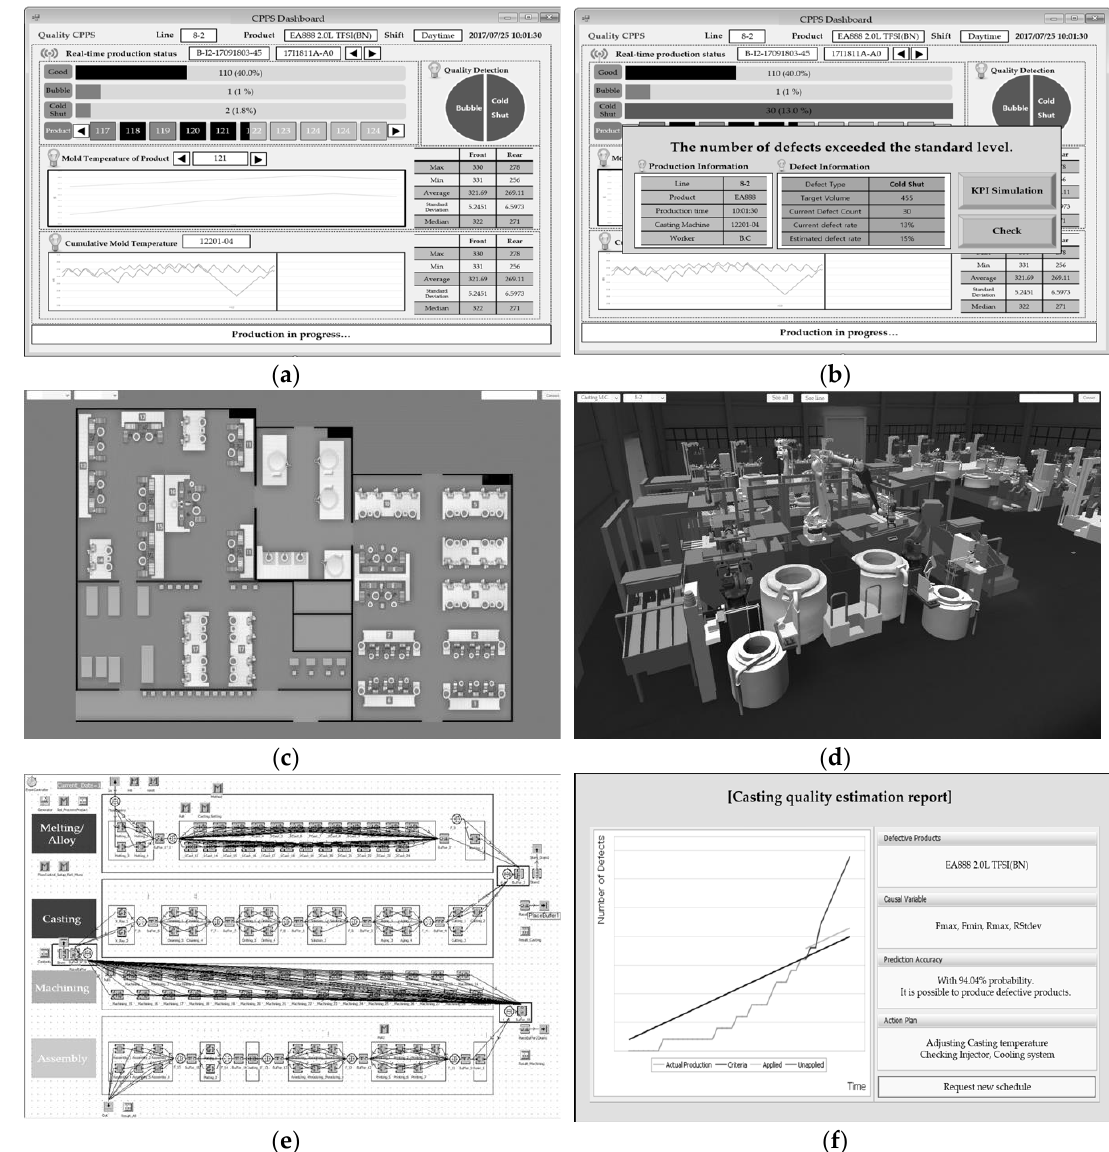
Figure 8. Screen shots of the CPPS dashboard: ( a ) screen shot for real-time monitoring; ( b ) screen shot for detecting defects; ( c ) screen shot for the factory layout; ( d ) screen shot of the 3D model for the casting line; ( e ) screen shot for the productivity simulation; ( f ) screen shot for requesting a new schedule.